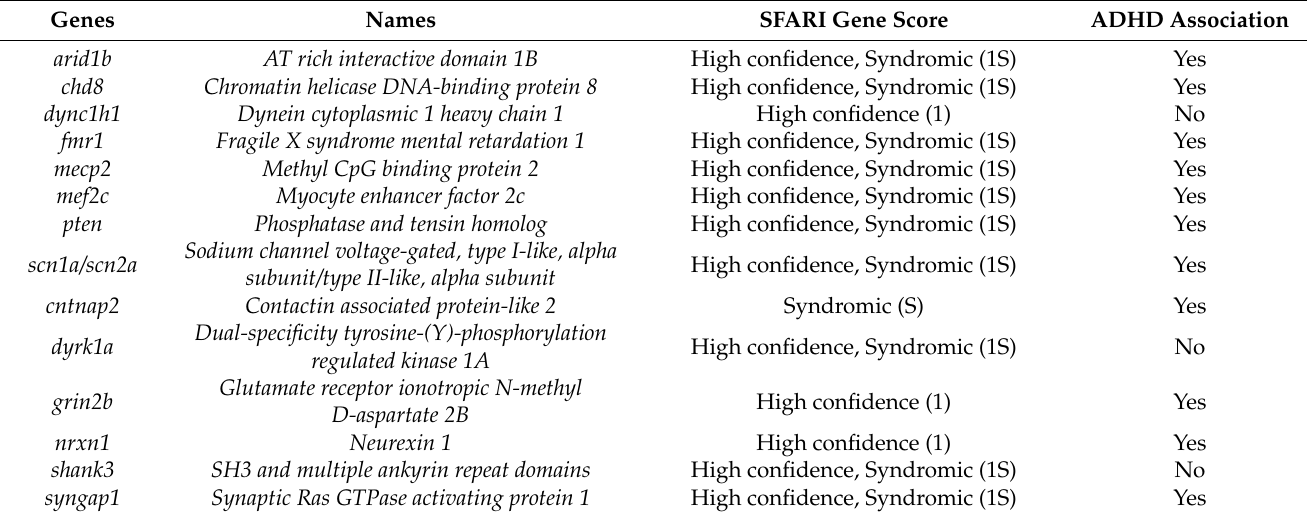
Table 9. Classification of some ASD genes according to SFARI. ASD gene classification and their ADHD association are